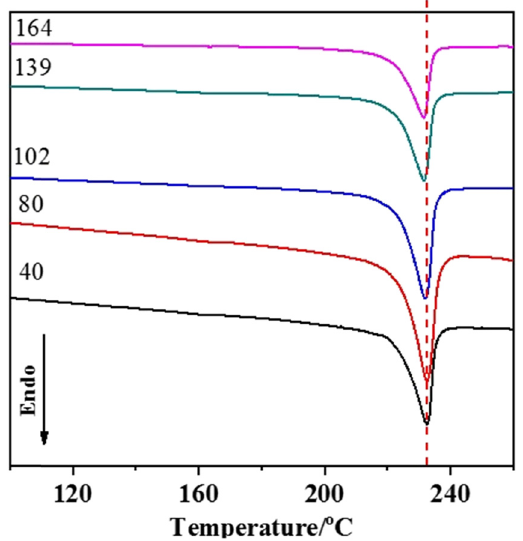
Figure 2: DSC curves of PMP casting fi lm with MDR from 40 to